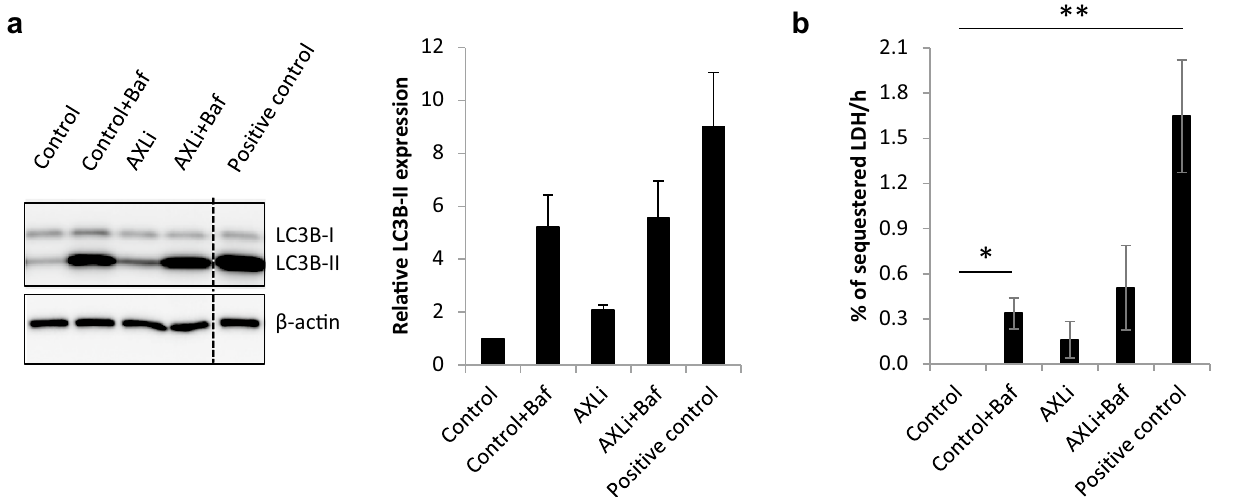
Figure 8. AXLi limits autophagic flux at a late stage in the autophagy pathway. Melmet 1 cells were treated with 1 µM AXLi for 48 h with or without co-treatment with 100 nM lysosomal inhibitor Bafilomycin A1 (Baf) for the 3 final hours of the treatment (DMSO for control). As a positive control, cells were in addition to Baf subjected to amino acid starvation by incubation in EBSS medium for 3 h. ( a ) Expression levels of indicated proteins in the differently treated cells. A representative western image is shown (cropped gel). Quantified expression levels of LC3B-II (after normalization to the loading control, β-actin) presented as relative to non-treated control set to 1. Average ± St. Dev, n = 2. ( b ) The LDH sequestered assay was performed and the results presented as the mean LDH sequestration activities (in %/h) in differently treated cells, normalized to the control set to 0. Average ± SEM, n = 3, * p ≤ 0.05; ** p ≤ 0.01.